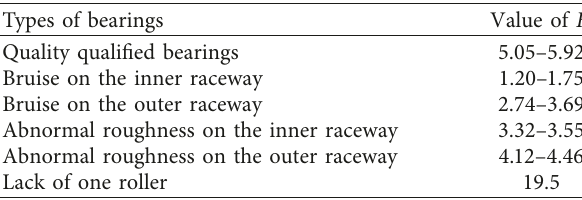
Figure 16: Pictures of bruise test bearings: (a) bruise on the outer raceway; (b) bruise on the inner raceway (Figure 6 in [24]). Table 3: Dynamic evaluation of test bearings.